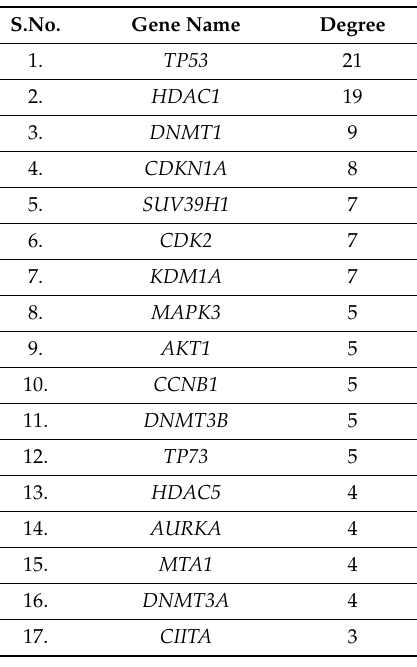
Table 2. Topological parameters of target gene